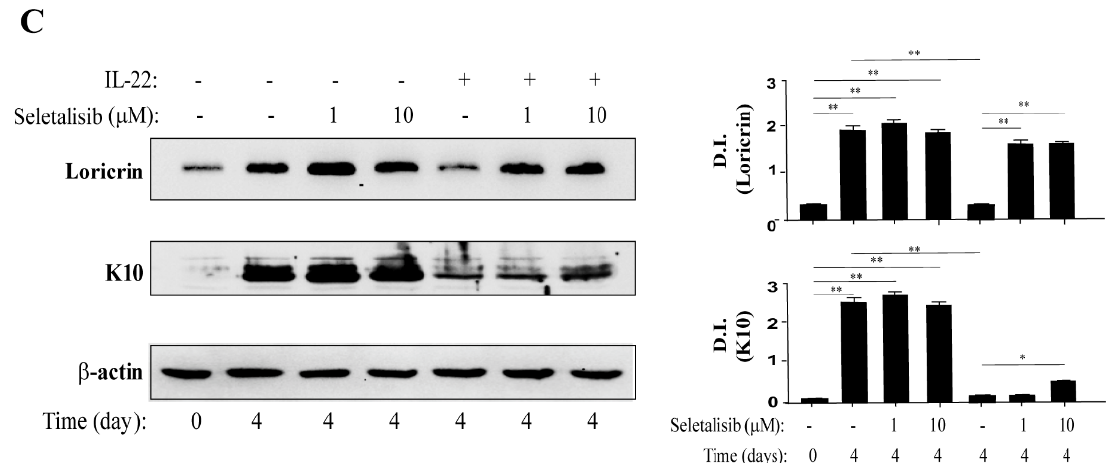
Figure 3. Selective PI3K δ inhibition interferes with cell proliferation, migration, and differentiation, induced by IL-22 in psoriatic keratinocytes. ( A ) CyQUANT proliferation assay was performed to determine cell growth of keratinocytes left untreated or grown in presence of IL-22 for 72 h, pre-treated or not with different doses (from 0.1 to 10 µ M) of seletalisb. Data are shown as mean values of fluorescence intensity obtained from three independent experiments ± SD. * p ≤ 0.05, ** p ≤ 0.01 calculated by one-way ANOVA test. ( B ) Scratch assays were carried out on keratinocytes left untreated or grown with IL-22, in presence or absence of seletalisib (1 µ M) for 9 h. Microscopic images were taken immediately after (T0) and 9 h after wound induction on confluent cell layers (T9h). Initial scratches (0 h) were marked with black dashed lines. Cell-free area was measured and indicated as residual wound. Data are reported as healed wound (blank area of bars) vs. residual wound (grey area of bars). Data are shown as mean of percentage values obtained from three independent experiments ± SD. * p ≤ 0.05 was calculated by one-way ANOVA test. ( C ) Keratinocyte cultures were subjected to culture conditions determining terminal differentiation. The latter was achieved by growing cells at 100% of confluence (T0) and, thus, keeping them in culture for another 4 days in presence or absence of increasing seletalisib doses. Where indicated, cells were stimulated with IL-22. Loricrin and K10 protein levels were analyzed by WB, and one representative analysis is shown. Graphs show the mean of D.I. of the indicated proteins normalized for β -actin observed in three different WB. * p ≤ 0.05 and ** p ≤ 0.01 assessed by one-way ANOVA test. ( A – C ) Multiple comparisons were performed by Tukey’s